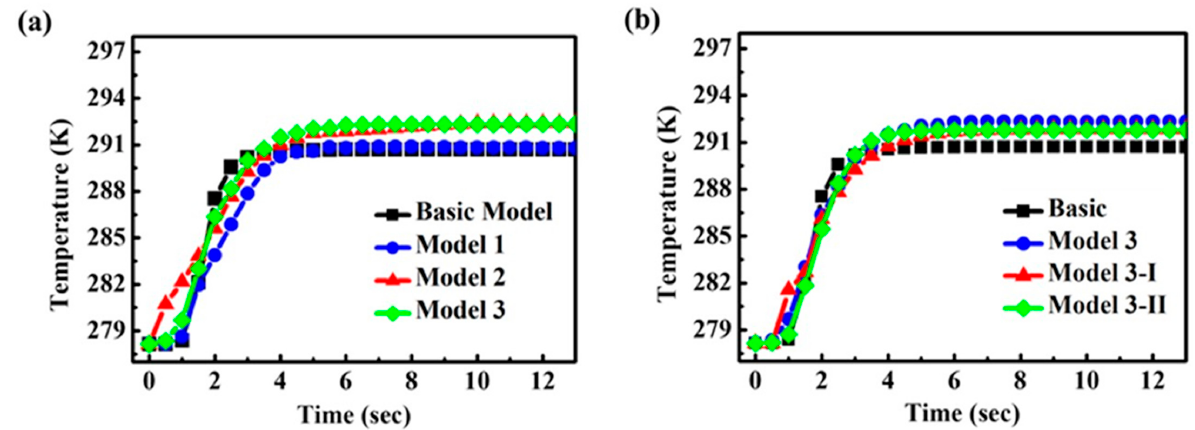
Figure 6. Temperature change for each model according to ( a ) different flow path shapes, ( b ) different number of flow paths.